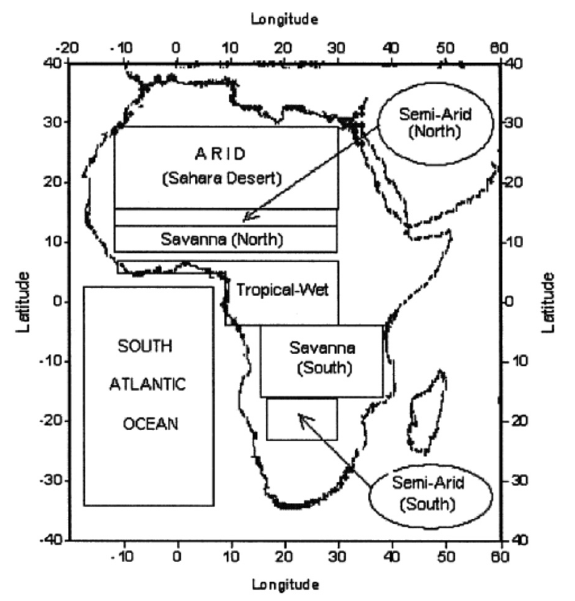
Figure 1. Major Climatic zones of Africa used in this study. Their geographical coordinates are specified in Table